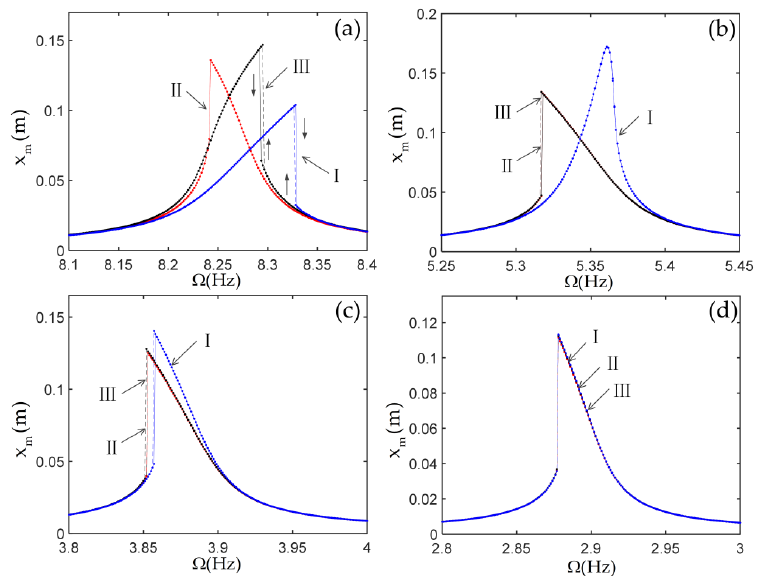
Figure 7. The frequency response curves of horizontal displacement of the tip mass: ( a ) m = 0,J = 0; ( b ) m = 0.2,J = 0.004; ( c ) m = 0.5,J = 0.01; ( d ) m = 1,J =